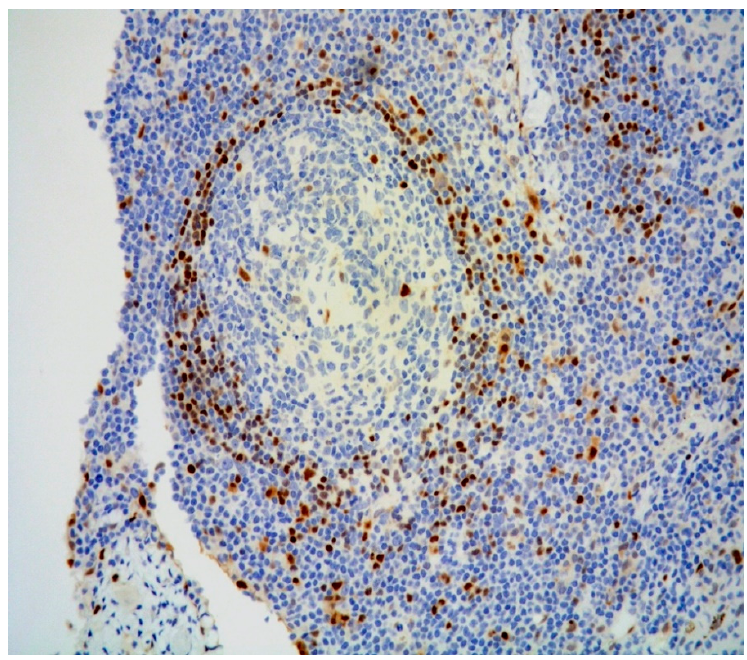
Figure 5. Cyclin D1-positive cells within the mantle zone of a reactive-appearing follicle (immunostain, 200× magnification).